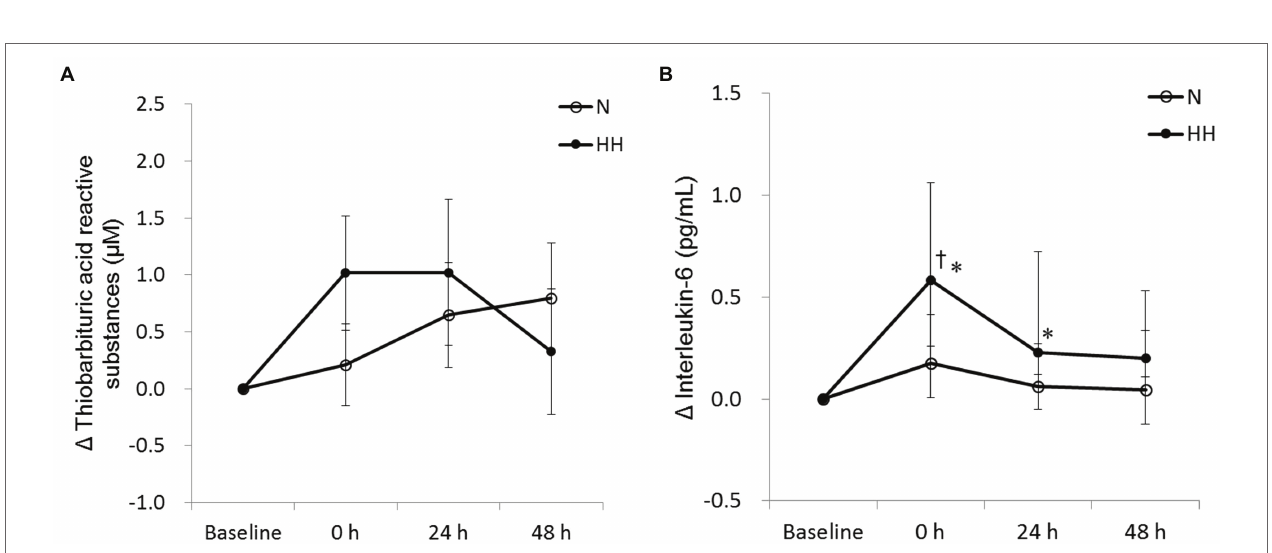
FIGURE 2 | Changes in circulating thiobarbituric acid reactive substances (TBARS; A ) and interleukin-6 (B) levels before preconditioning and post-exercise in N and HH trials. The values of TBARS and interleukin-6 are presented mean ± SE or 1st quartile median–3rd quartile, respectively ( n = 11). N, normoxia; HH, hypoxia– hyperoxia. † p < 0.05 vs. Baseline. * p < 0.05 vs. N